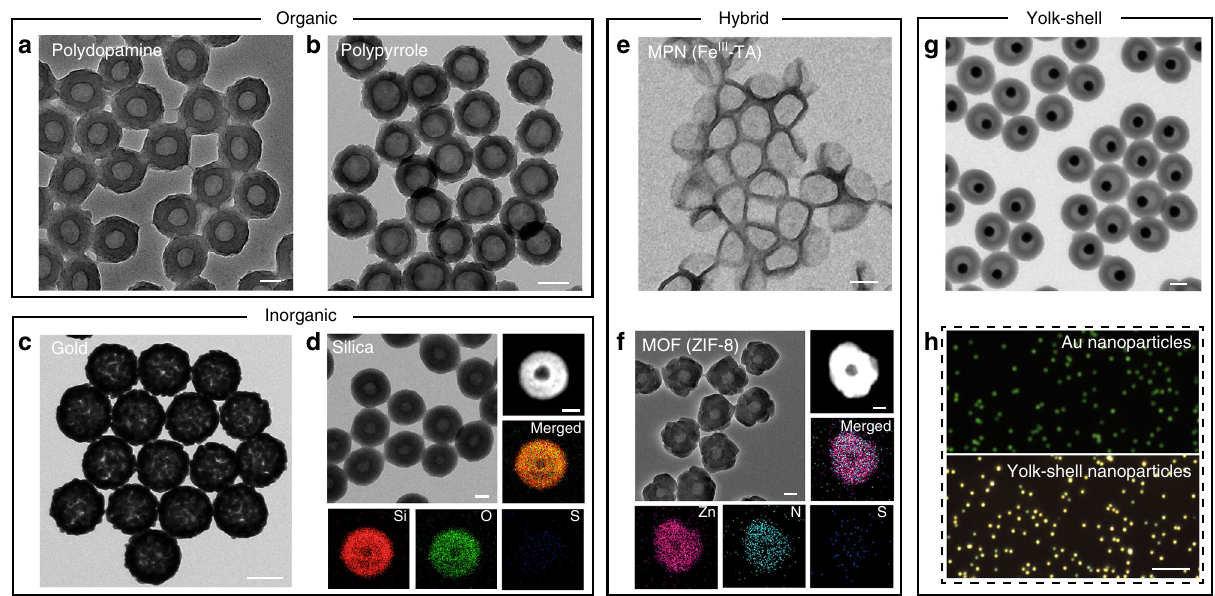
Fig. 4 Synthesis of hollow particles using sacri fi cial pBDT – TA particles. a – f TEM images of hollow structures after removal of the pBDT – TA core. Insets in d and f are HAADF-STEM images of representative hollow particles and their corresponding EDX mapping results. g TEM image of AuNP@polydopamine yolk – shell NPs. h Dark- fi eld images of 50 nm AuNPs and AuNP@polydopamine yolk – shell NPs. Scale bars are 100 nm ( a – g main images and insets) and 10 µ m h